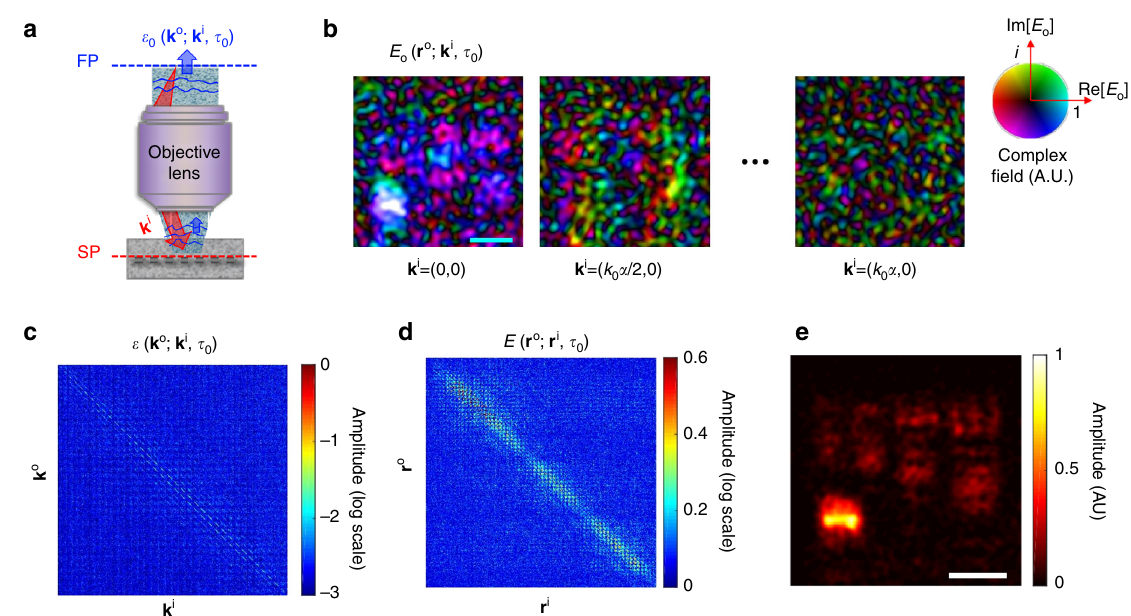
Fig. 2 Experimental measurements of a time-resolved re fl ection matrix. a Layout of the experimental recording of the time-resolved re fl ection matrix. For each incident wavevector k i , the complex fi eld maps of the backscattered waves were recorded at the fl ight time of the single-scattered waves. SP sample plane, FP Fourier plane. b Complex fi eld maps of the backscattered waves recorded experimentally. Only a few representative images are shown out of the total 2800 images. Scale bar, 4 μ m. Images are normalized by their respective maximum amplitudes. The saturation and colour of the colour bar indicates ffiffiffiffiffiffiffiffiffiffi p (cid:1) (cid:3) ð(cid:2) 1 Þ the amplitude and phase of the complex fi eld, respectively, and i = . c Reconstructed time-resolved re fl ection matrix E k o ; k i ; τ 0 in the wavevector space. Column and row indices are k i and k o , respectively. Color bar, log-scaled amplitude. d Time-resolved re fl ection matrix E r o ; r i ; τ 0 ð Þ in the real space converted from ( c ). Column and row indices are r i and r o , respectively. Color bar, amplitude in arbitrary unit. e Reconstructed object image from the diagonal components in ( d ). Color bar, intensity normalized by the maximum intensity. Scale bar, 4 μ beam from a Ti:Sapphire laser (center wavelength: 800 nm, temporal pulse width: 80 fs, and average output power: 600 mW)